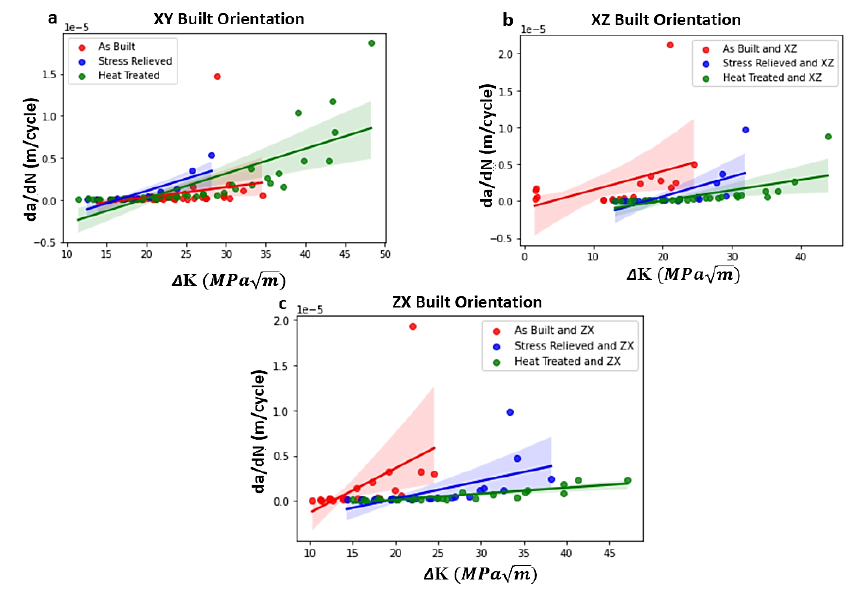
Figure 1. Experimental FCGR data in Ti-64 alloy ( a ) XY Specimen Orientation; ( b ) XZ Specimen Orientation and ( c ) ZX Specimen Orientation. Orientation and ( c ) ZX Specimen